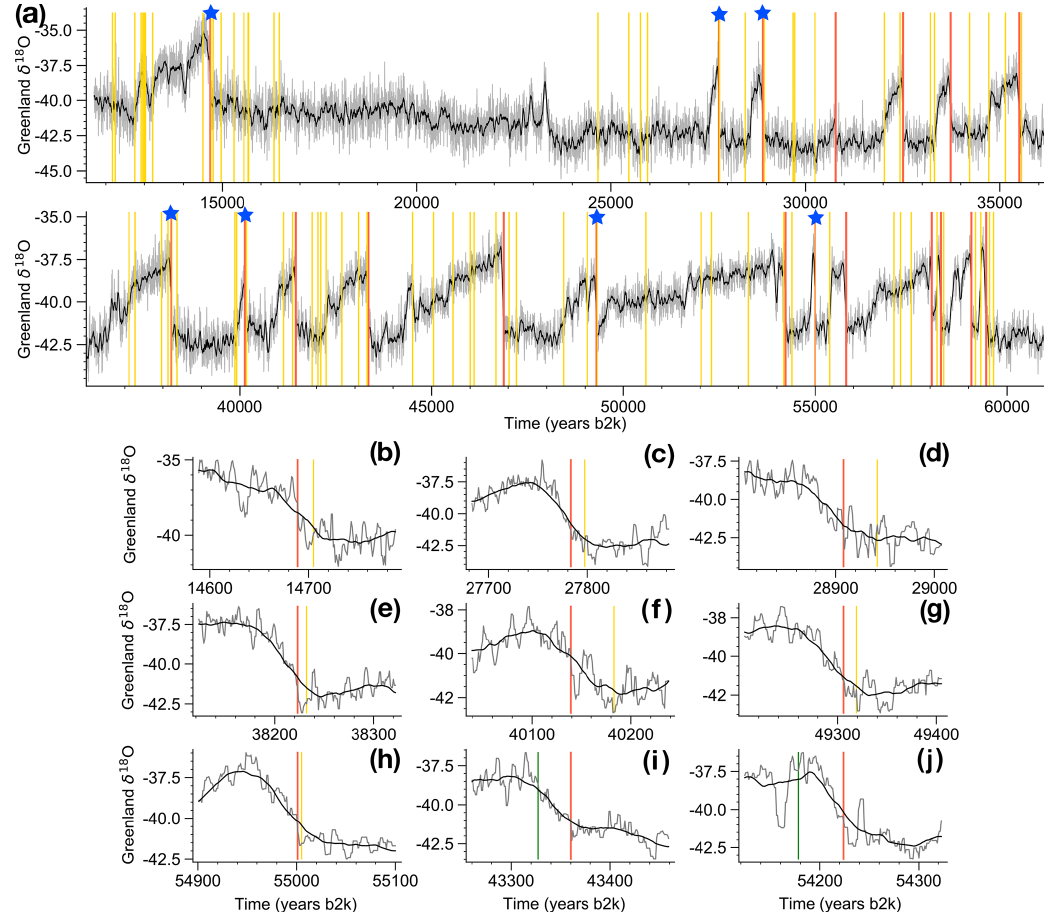
Figure 1. Records of abrupt climate change and bipolar volcanism during the last glacial period. (a) High-resolution Greenland δ 18 O stack (gray, see Sect. 2.1) and 50-year low-pass-filtered stack (black), together with the estimated onsets of the DO warmings (red, this work) and the bipolar volcanic eruptions (yellow, SVE20). For the interval 16.5–24.5ka no bipolar volcanic eruptions have been identified as the ice cores are difficult to synchronize. The blue stars indicate instances in which a volcanic eruption occurs within 50 years prior to the DO warming. The corresponding segments are shown magnified in panels (b) – (h) . For comparison, panels (i) – (j) show the only two instances in which a bipolar eruption (marked in green) occurs within 50 years after the DO warming